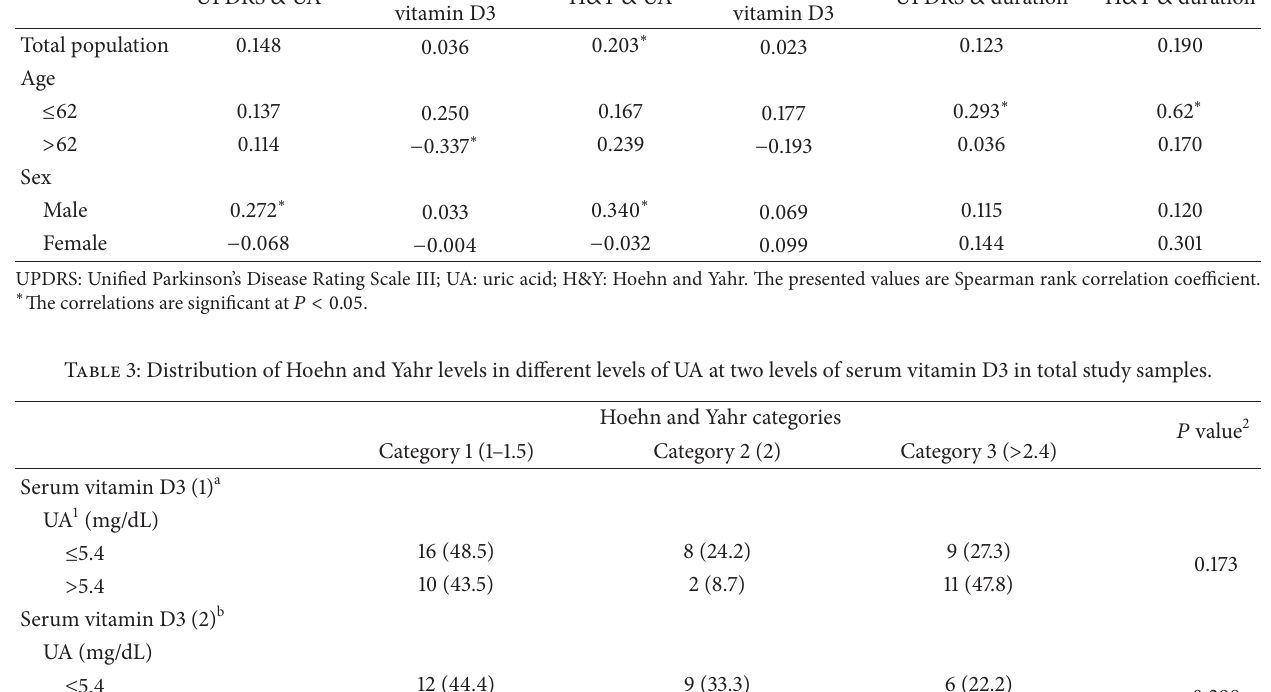
Table 2: The bivariate correlation between serum vitamin D3, UA levels, duration of disease and UPDRS, and Hoehn and Yahr scores in total sample and different age and sex groups.